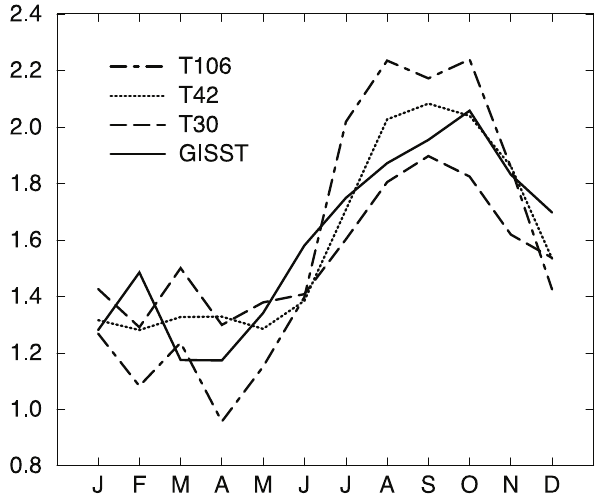
Fig. 18. Seasonal modulation of the DMI, computed as the monthly means of the amplitude of the DMI. Solid line curve: GISST data set; dot-dashed curve line: T106 experiment; dotted line curve: T42 experiment; dashed line curve: T30